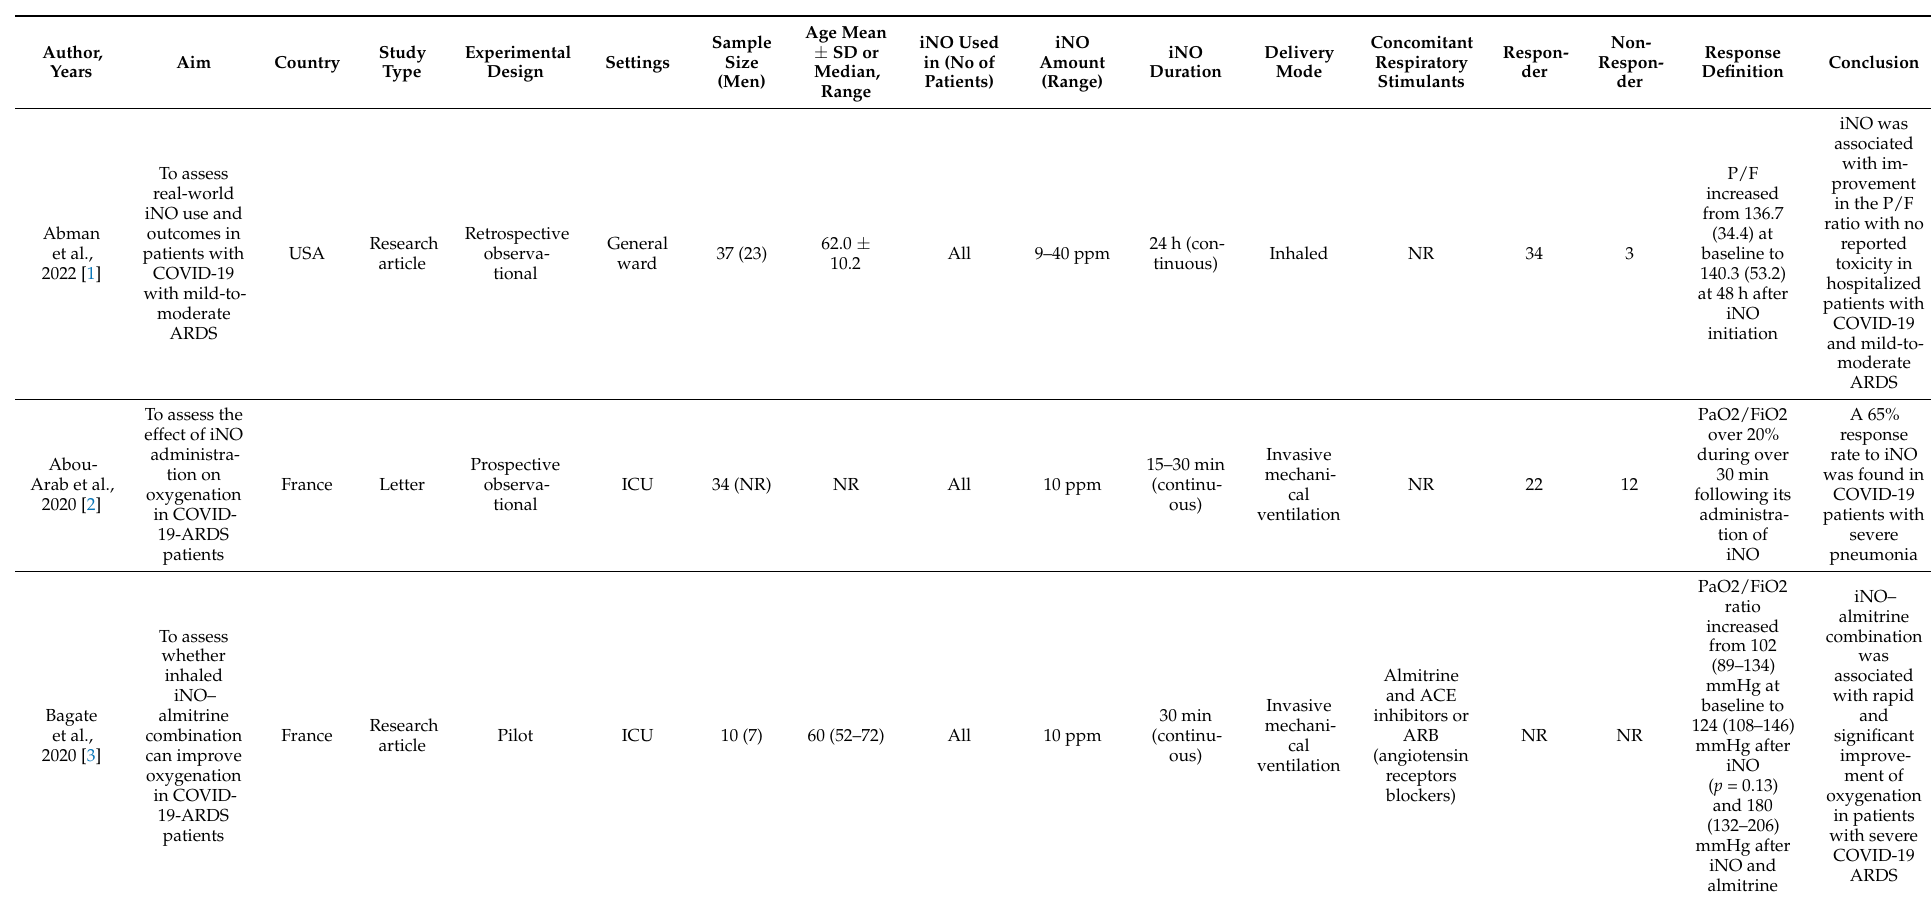
Table 1. General characteristics of studies included in systematic